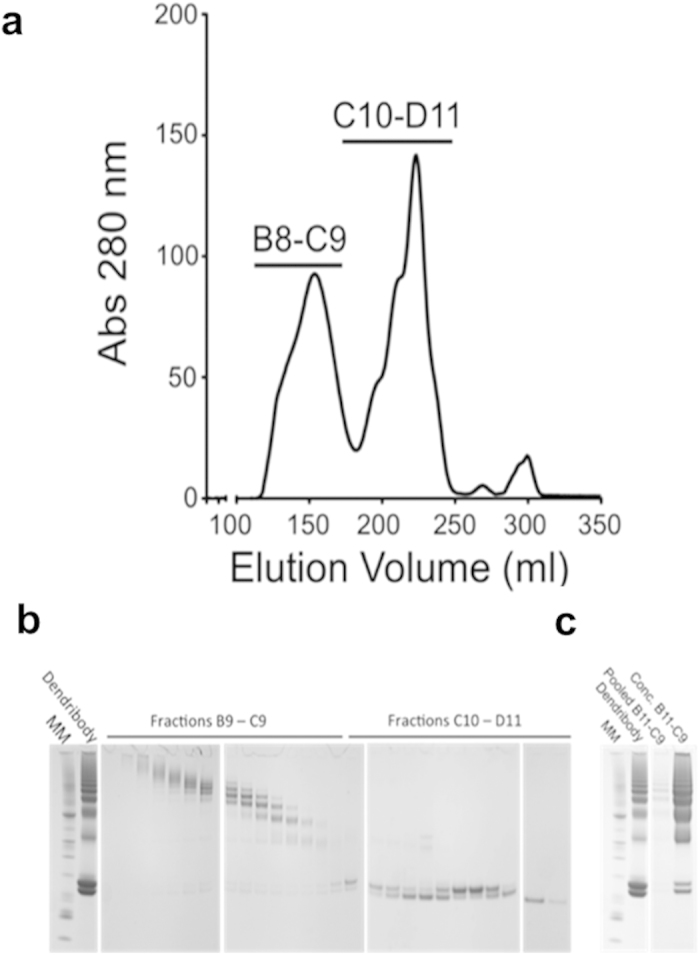
a Separation profile of dendribodies from unreacted scFv7F9Cys using size exclusion chromatography. Peak assignments: (B8-C9) dendribodies and (C10-D11) PEG modified and unreacted scFv7F9Cys. b SDS-PAGE analysis of the fractions. c, SDS-PAGE analysis of pooled and concentrated elution fractions B11-C9.